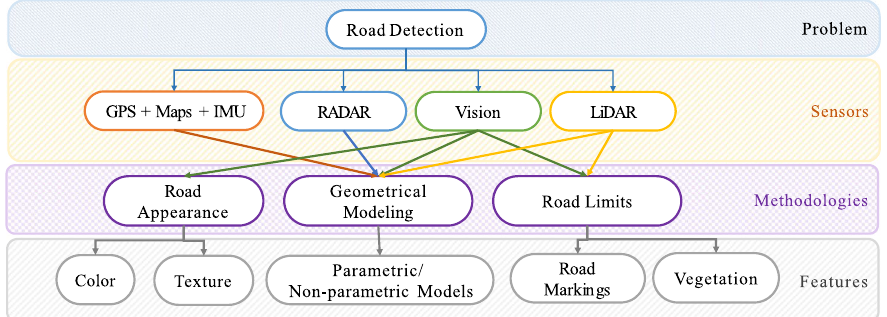
Fig. 2 Various approaches to road